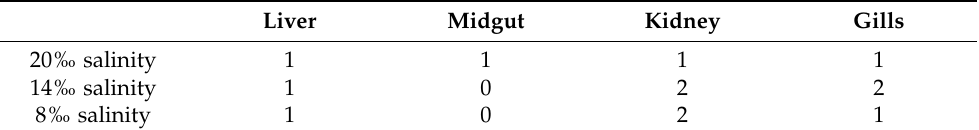
Table 4. Severity scoring for the observed histopathological alterations of sea bream in different levels of salinity.